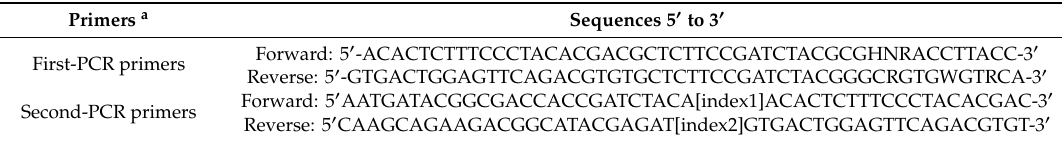
Table 1. Primers used for PCR amplification of the 16S rRNA